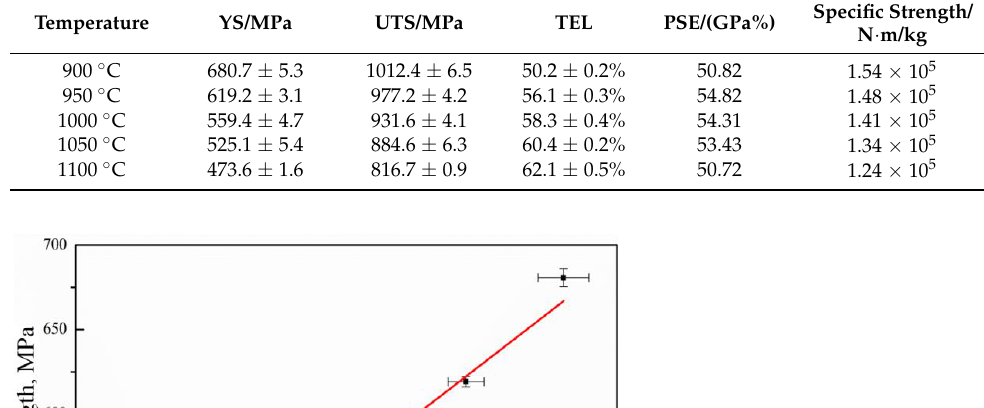
Table 2. Mechanical properties of experimental steel under different annealing conditions.